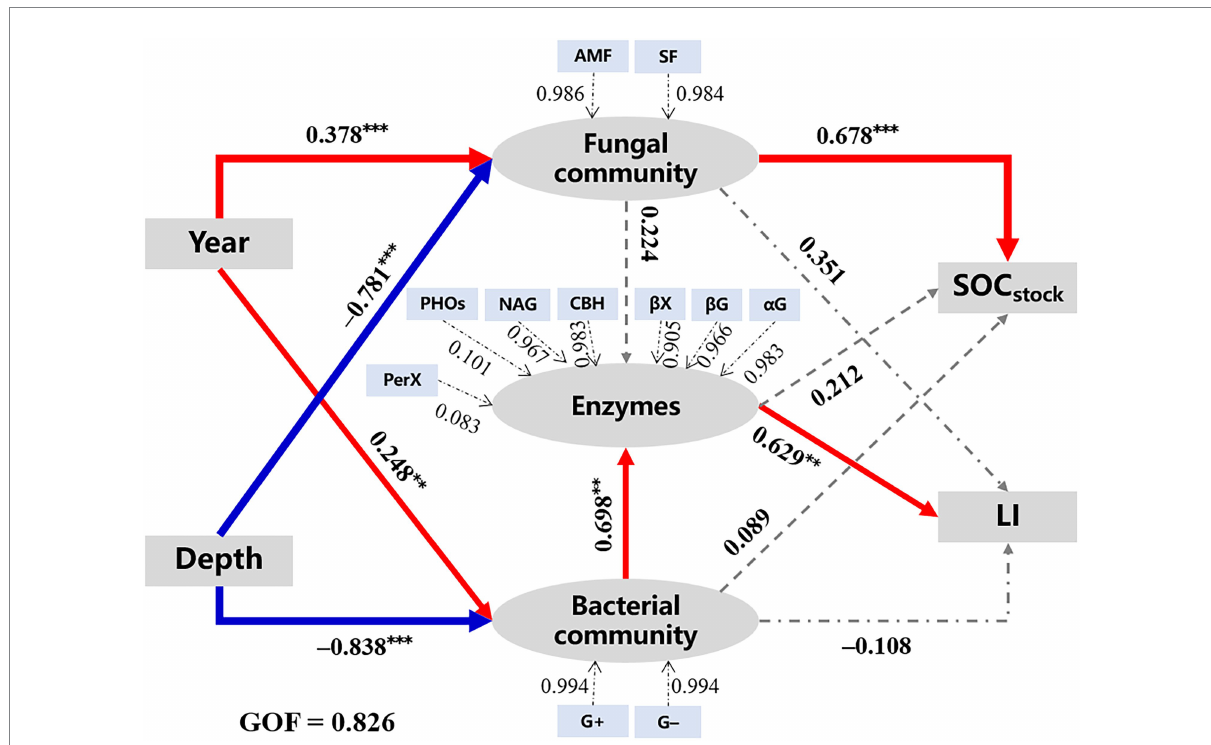
FIGURE 5 The PLS-PM analysis demonstrates how walnut plantation ages and soil depths affected the quantity and quality of SOC by regulating microbial characteristics. The red lines represent positive effects, while the blue lines represent negative effects. Besides, the grey lines represent non- significant effects ( p > 0.05). The widths of the lines represent the strength of the effects. The values above the arrows represent path coefficients (** p < 0.01 and *** p < 0.001). The values of goodness of fit (GOF) denote the goodness of fit index. G+, Gram-positive bacteria; G − , Gram-negative bacteria; AMF, arbuscular mycorrhizal fungi; SF, saprotrophic fungi: other abbreviations see Tables